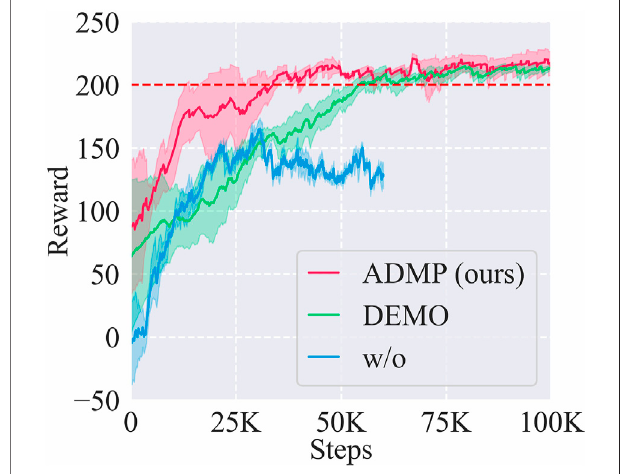
Frontiers in Robotics and AI |